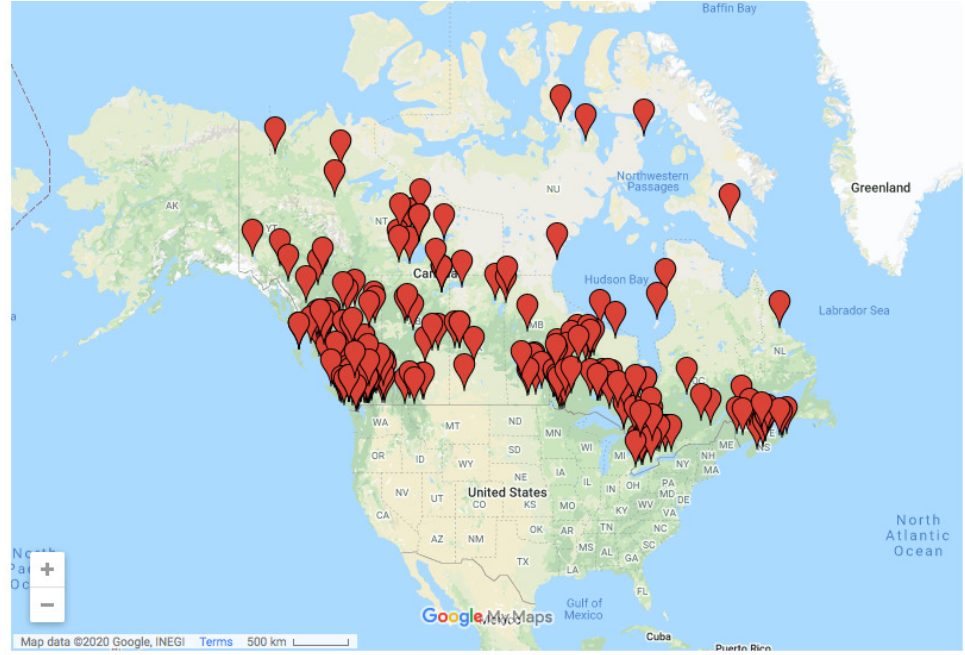
Figure 5: Indigenous renewable energy developments in Canada. Source: www.indigenousenergy.ca. Created by the author and